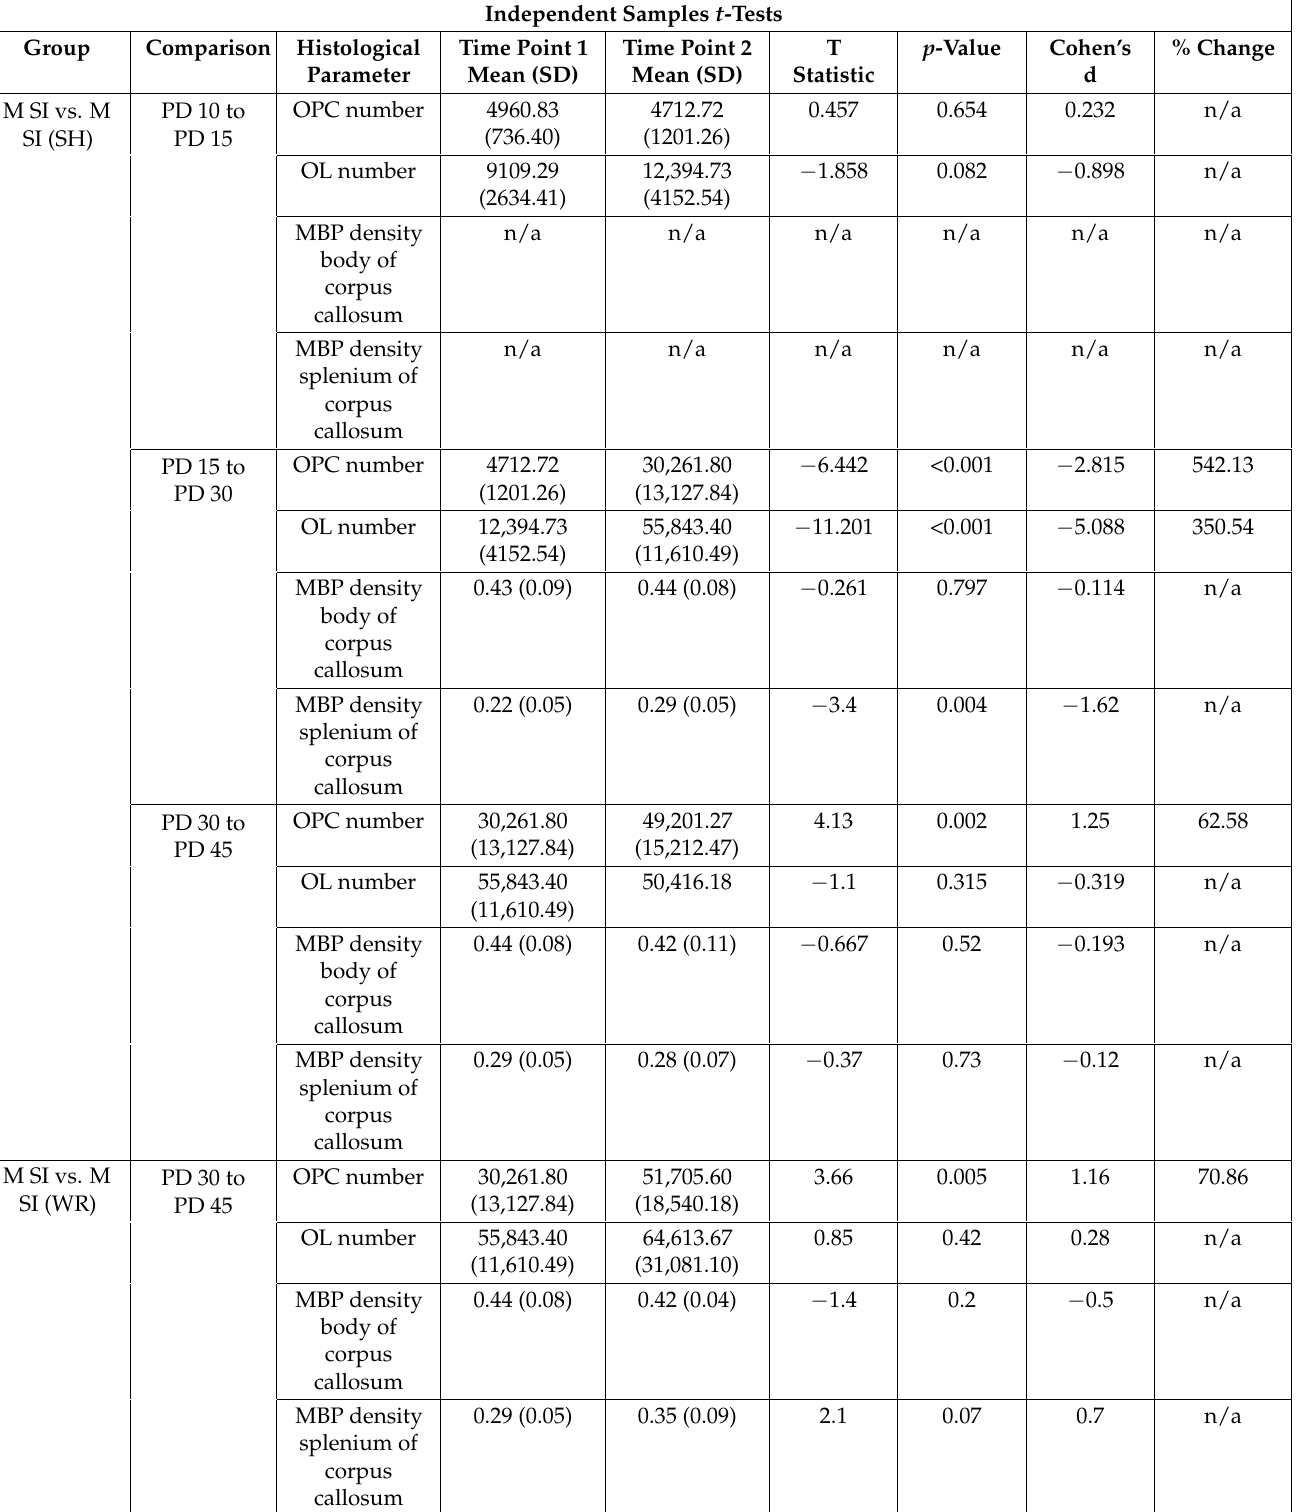
Table 2. Results from t -tests comparing measurements of histological parameters between time points. Independent Samples t